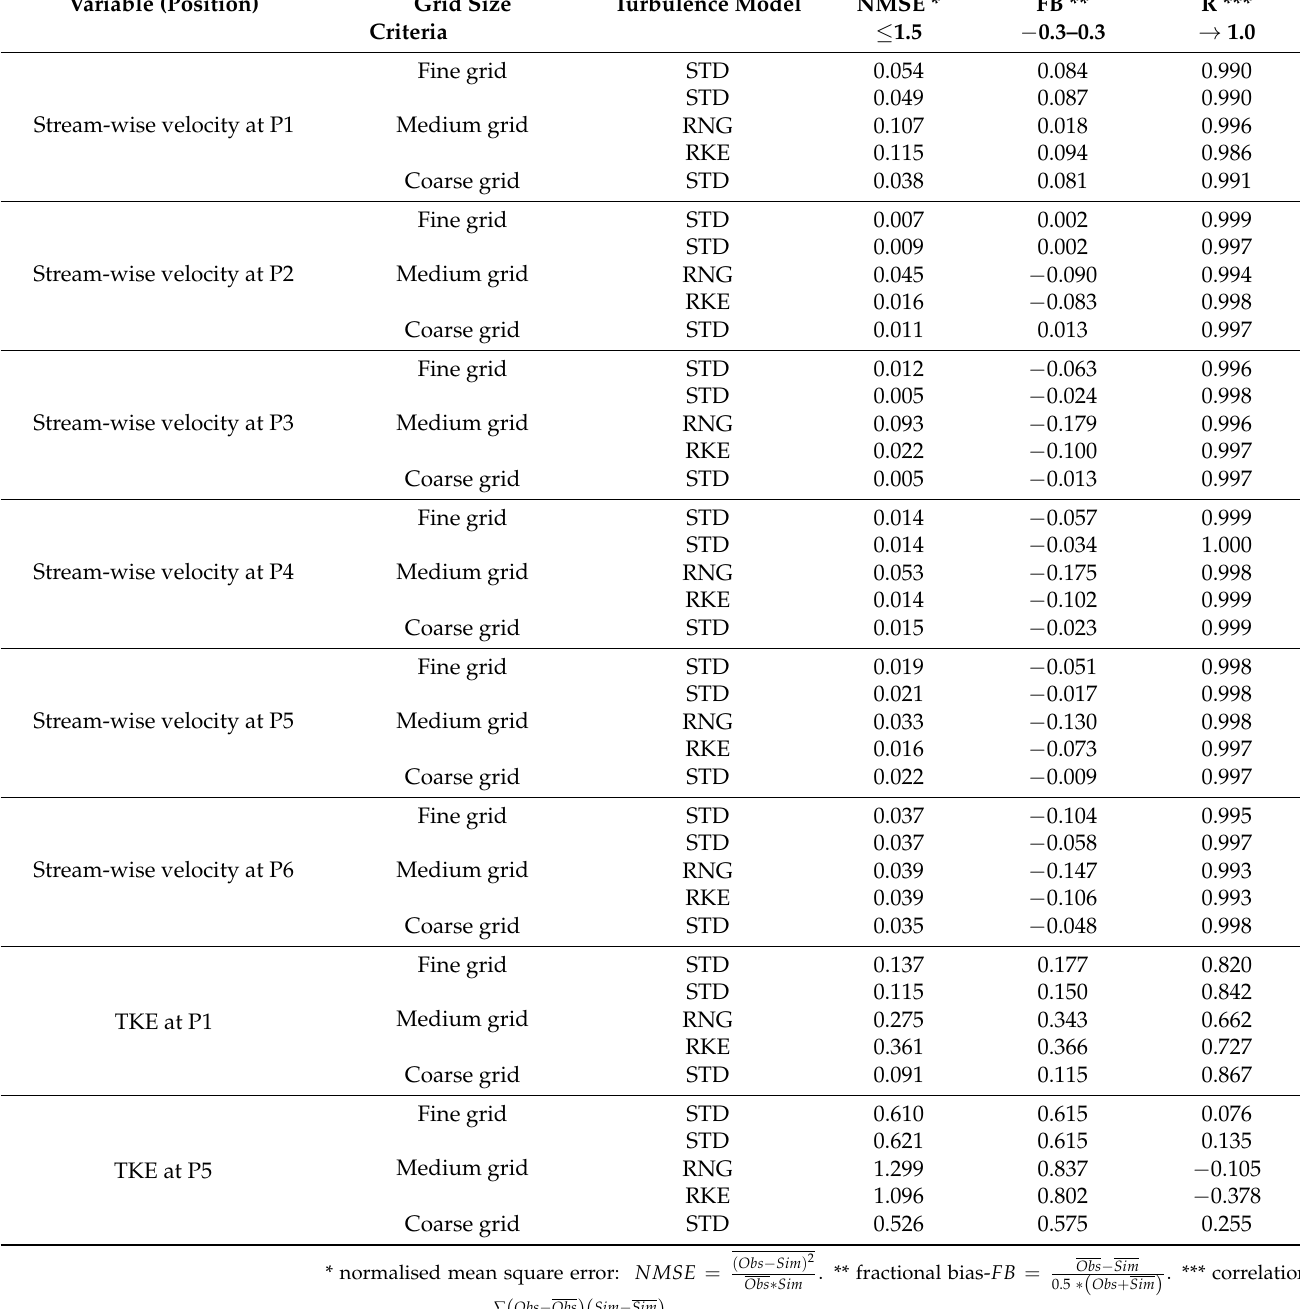
Table A2. Statistical analysis between wind tunnel data and CFD simulation results—flow